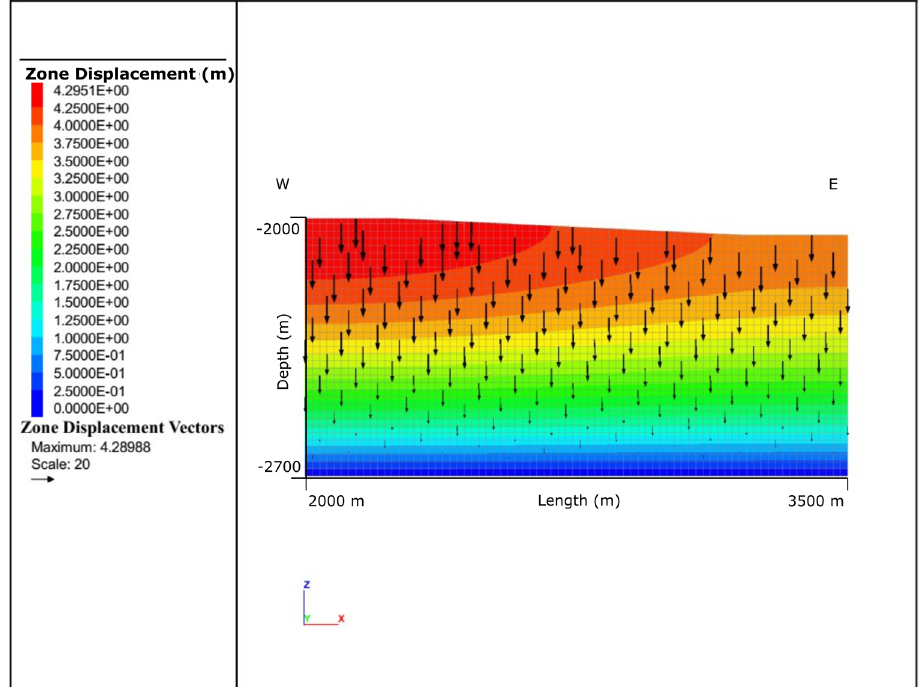
Figure 9. Displacement (m) due to depressurized production for 180 days. The maximum displace- ment reaches 4.28 m. The displacement vectors suggest that there is subsidence in the reservoir due to hydrate dissociation and reduction in pore